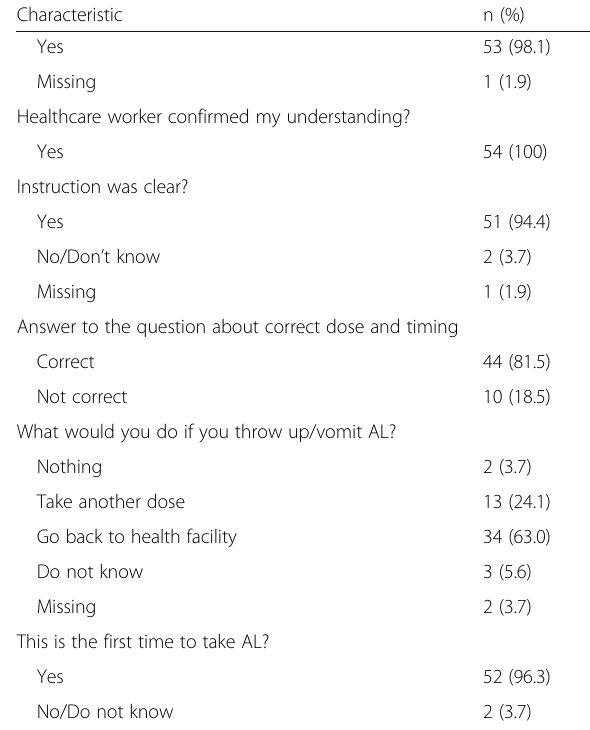
Table 1 Socio-demographic and patient characteristics in the patient study (n=54) Characteristic